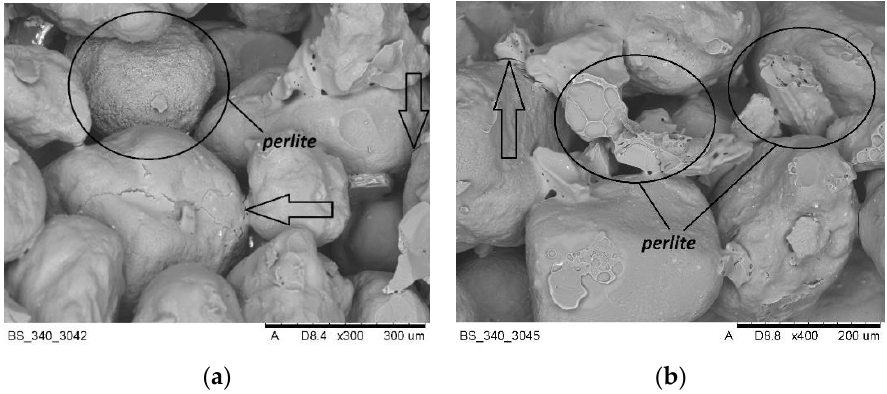
Figure 17. SEM imaging of moulding sand with SP1 perlite ore after annealing at 800 °C: ( a ) magnification 300×, ( b ) magnification 400×.